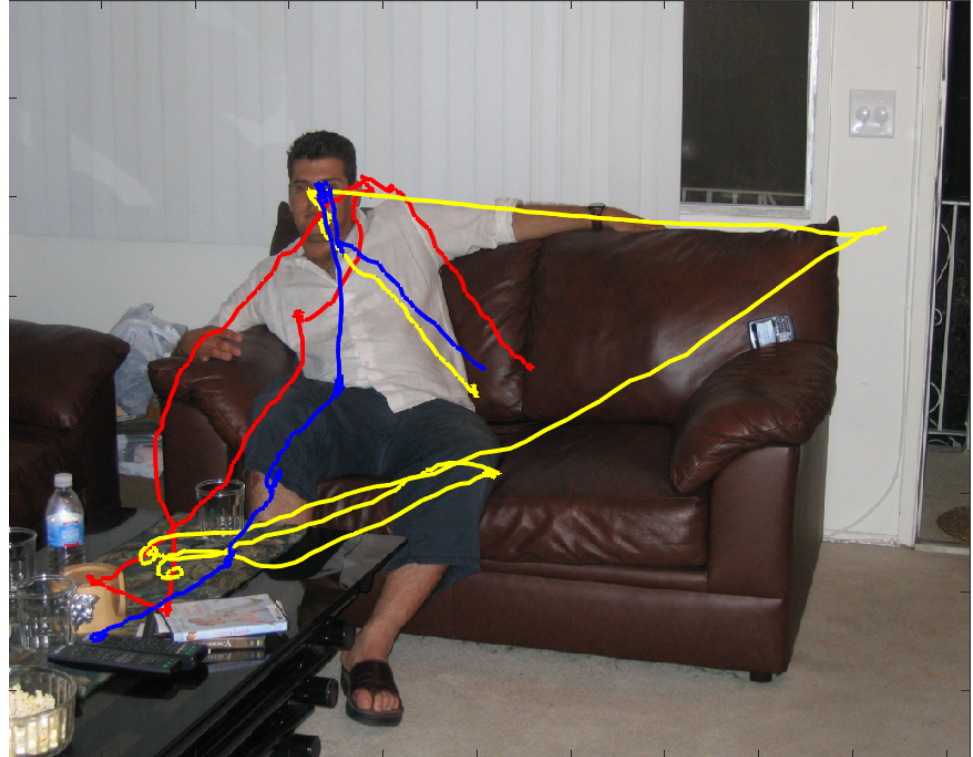
Figure 1. Gaze dynamics of three different observers while scrutinising for 2 secs the image and recorded through an eye-tracking device. The unfolding of gaze deployment of each observer is displayed as a coloured trajectory (blue, yellow and red, respectively) overlapping the viewed image. The onset of gaze unfolding is approximately located at the center of the image for all viewers. Image and eye-tracking data are publicly available from the FIFA dataset